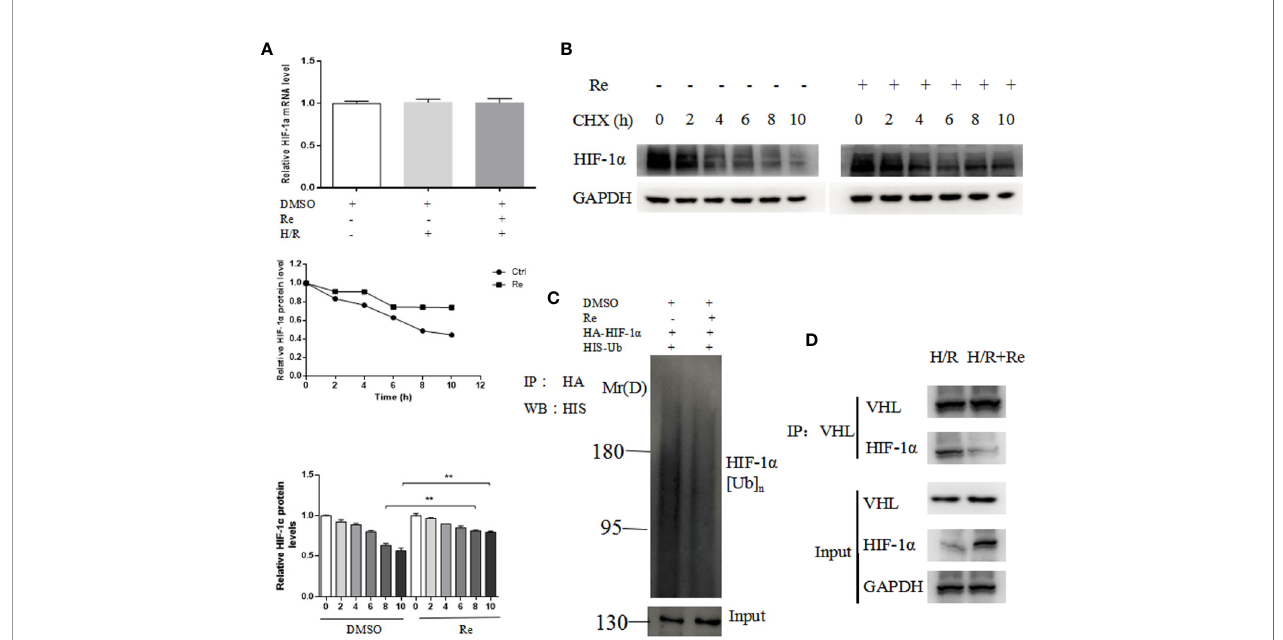
FIGURE 4 | Ubiquitination of HIF-1 a following ginsenoside Re treatment. (A) HIF-1 a mRNA level. (B) Half-life of HIF-1 a protein. (C) HIF-1 a ubiquitination following ginsenoside Re treatment. (D) Interaction between VHL and HIF-1 a following ginsenoside Re treatment. All data are shown as mean ± SEM, ** P < 0.01. Ctrl, control; RE, ginsenoside Re; DMSO, Dimethyl sulfoxide.